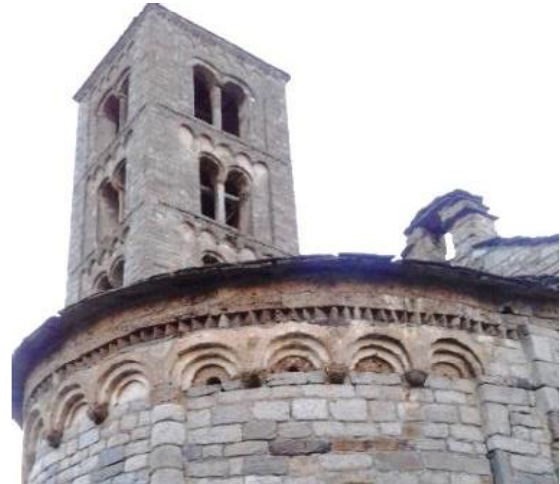
Figure 5. Romanesque, Sant Climent de Taüll year 1123 AD. Photo: César